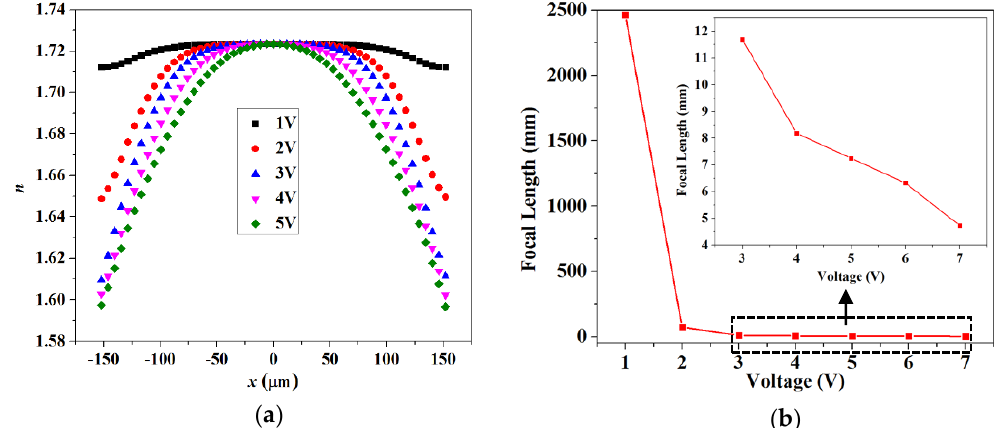
Figure 3. Simulated ( a ) refractive index distribution of the cylindrical LC lens array with different operating voltages and ( b ) voltage-dependent focal length of the cylindrical LC lens array.